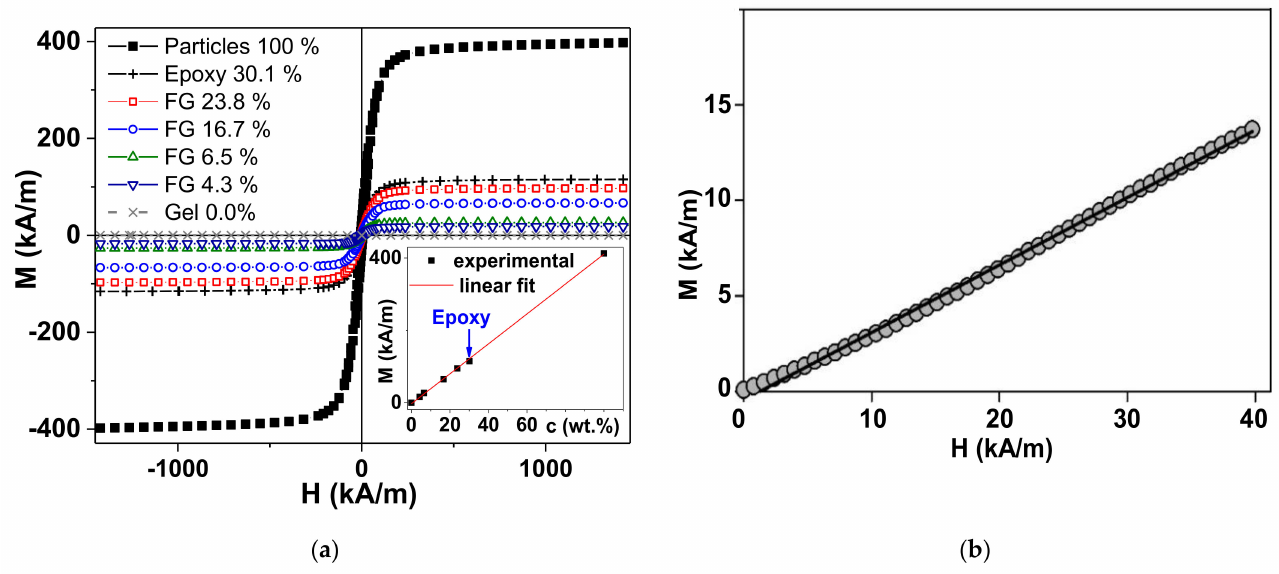
Figure 3. Magnetic hysteresis loops of magnetite particles in the VSM: ( a ) Magnetite particles (Parti- cles 100%), ferrogels with different concentration of the magnetite particles used as a filler (FG 23.8%, FG 16.7%, FG 6.5%, FG 4.3%, Gel 0.0%—the numbers correspond to the weight percent of the parti- cles), and epoxy composite with 30.1 wt.% of the particles. Inset shows the concentration dependence of the magnetic moment of the samples of different types mentioned above for the magnetization measured in the external field of 1450 kA/m, being close to saturation magnetization. Points are experimental data, a line is the linear fit, the arrow indicates the point corresponding to model epoxy composite; ( b ) the low-field dependence of the initial magnetization (primary magnetization curve) of the model epoxy sample (sphere) with 30% (wt.) of magnetite particles, measurement performed starting with the demagnetized state. The solid lines are guides for